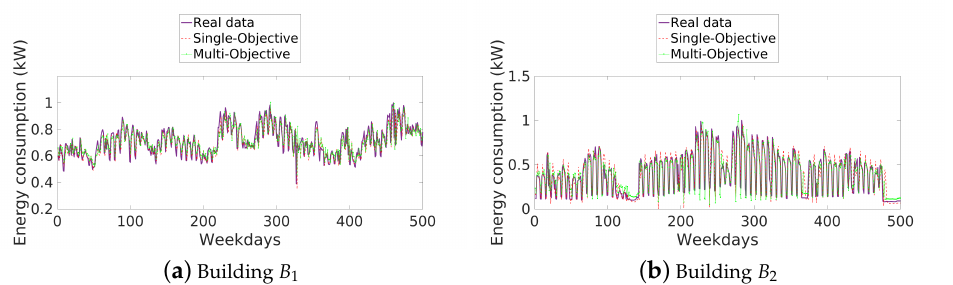
Figure 9. Real and predicted energy consumption from both single- and multi-objective approaches in cluster of buildings E 1 .